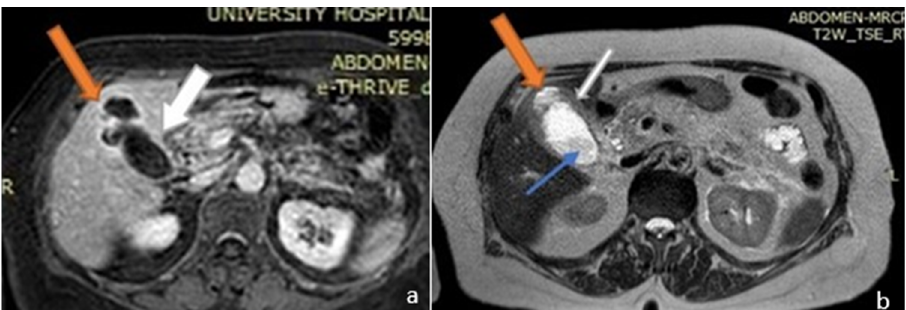
Figure 1. Magnetic resonance imaging (MRI) image of the upper abdomen. ( a ) Axial T1 post contrast and ( b ) T2. The gall bladder mucosa shows interrupted enhancement with a localized perforation anteriorly, close to the fundus. Orange arrows: liver abscess; white arrows: gallbladder; blue arrow: gallbladder stone.